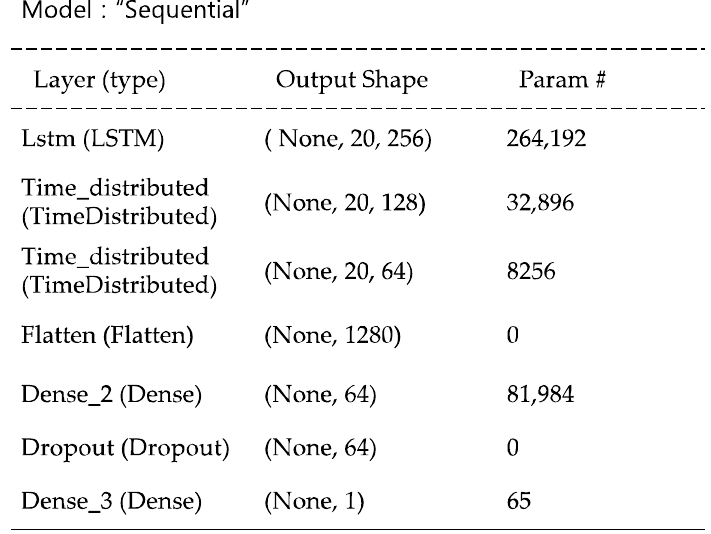
Figure 10. RvNN model architecture.